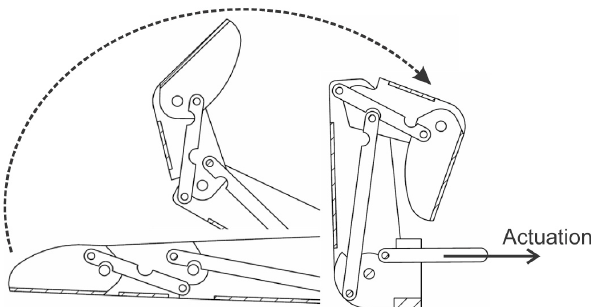
Figure 1. Links between the interphalangial joints cause the finger to flex as it closes. the finger closes progressively, but if the lower phalanx is halted by an external object the tips cannot continue to move.